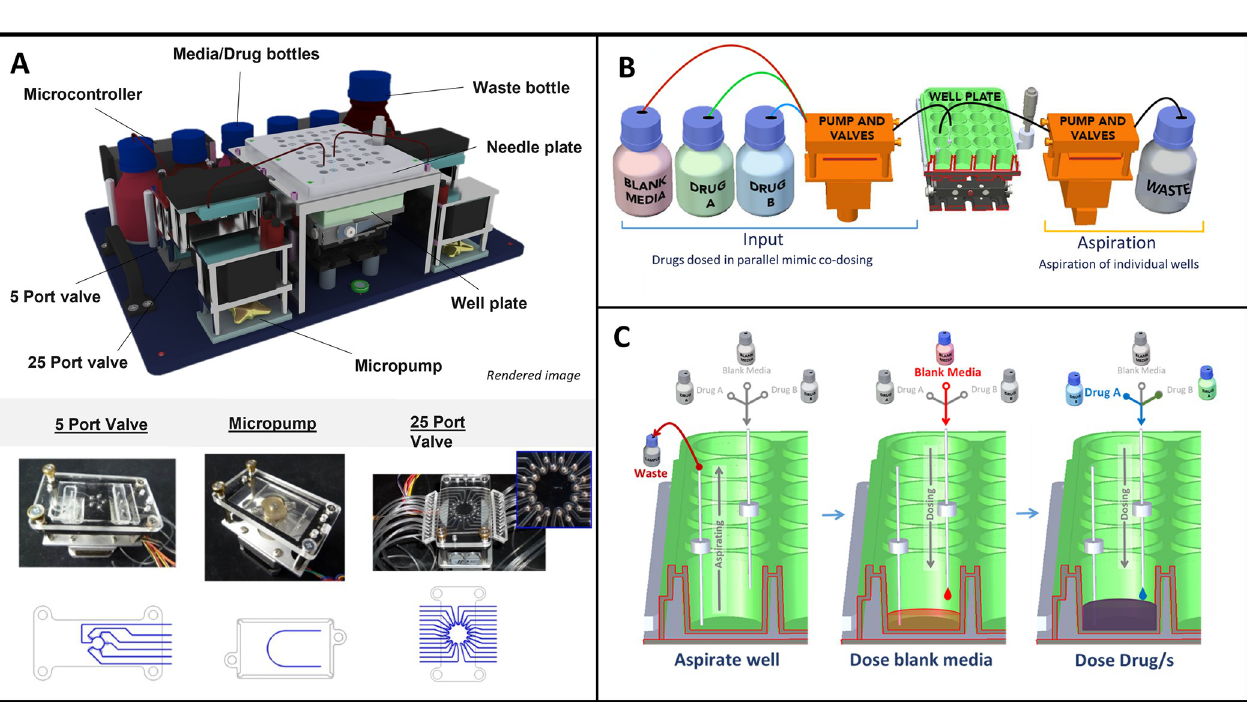
Fig 2. The Microformulator, a microfluidic device used to accurately dose and aspirate media from individual wells of a standard microtiter plate. (A) 3D render of the Microformulator device showing various component parts. Photographs of a micropump and valves and the fluidic paths within those devices are shown below. (B) Schematic representation of the Microformulator setup, split into an input side and an aspiration side. During each sweep/cycle media is pumped from input bottles through a series of valves into the well plate. On the aspiration side, media is drawn from the wells through a 25-port valve and pumped into waste. (C) Schematic representation of media addition and removal from each well on a microtiter plate using the Microformulator. Blank media and media containing drug/s are dosed into the well from different bottles to regularly change the concentration within the well.